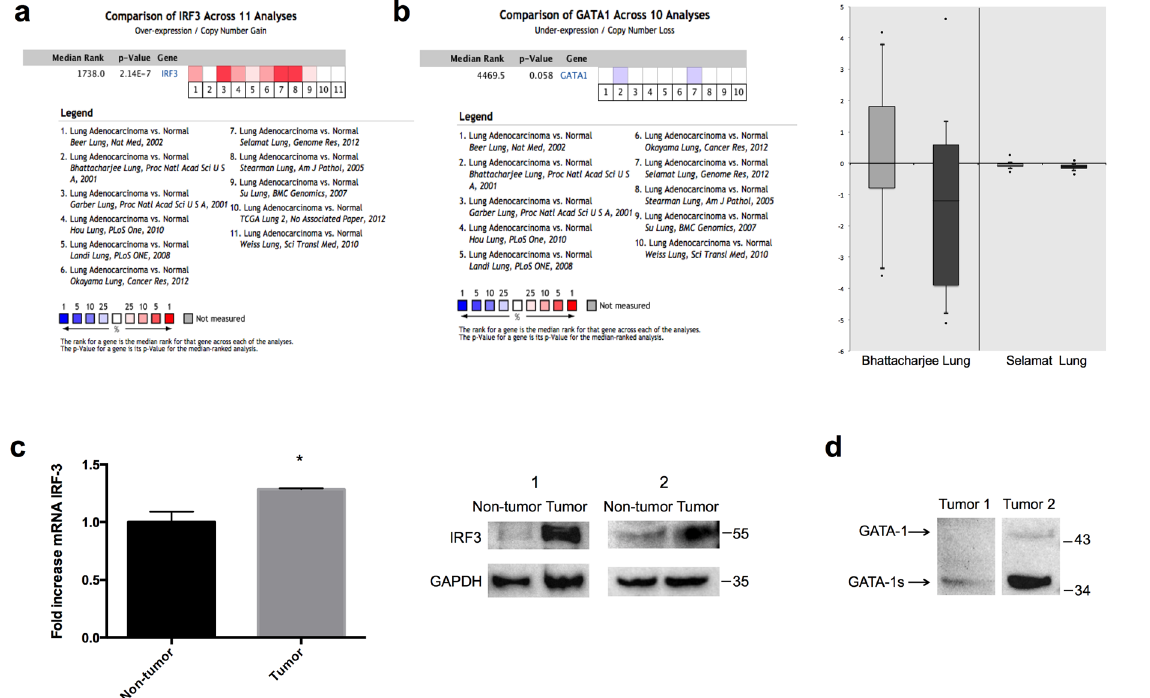
Figure 3. Upregulation of IRF-3 protein expression and down-regulated expression of GATA-1 protein in human lung adenocarcinoma tissue. ( a ) Eleven analyses were evaluated in comparing the RNA expression of IRF-3 between lung adenocarcinoma and normal tissue. Values above the average were considered IRF-3 over-expression (red). ( b ) Ten analyses of GATA1 gene demonstrated the different expression in lung adenocarcinoma compared to normal tissue. Lower expression of GATA1 was shown in two studies (blue). These two studies, Bhattacharjee Lung and Selamat Lung datasets studies, showed GATA-1 expression in normal tissues (light grey) and lung adenocarcinoma (dark grey). Log2 Median-Centered ratio was used to average all normal samples in data analysis. ( c ) The endogenous IRF-3 mRNA and protein expression was examined in lung adenocarcinoma and adjacent normal tissue. P values were determined by Student’s-t test ( * p < 0.05). ( d ) The GATA-1 protein expression was detected in lung adenocarcinoma tissue by Western blot. GAPDH was used as a internal control. The full-length blots were presented in Supplementary Figure